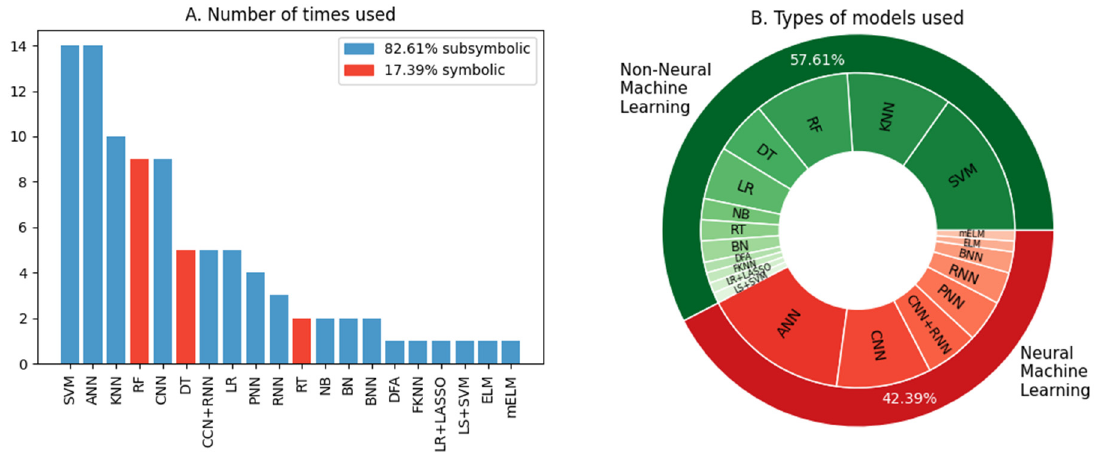
Figure 3. ( A ) models and the number of times they are considered in the articles, indicating their belonging to either the symbolic or subsymbolic processing group. ( B ) Pie chart of the types used, specifying the non-neural ML techniques and those belonging to the ANN subgroup.